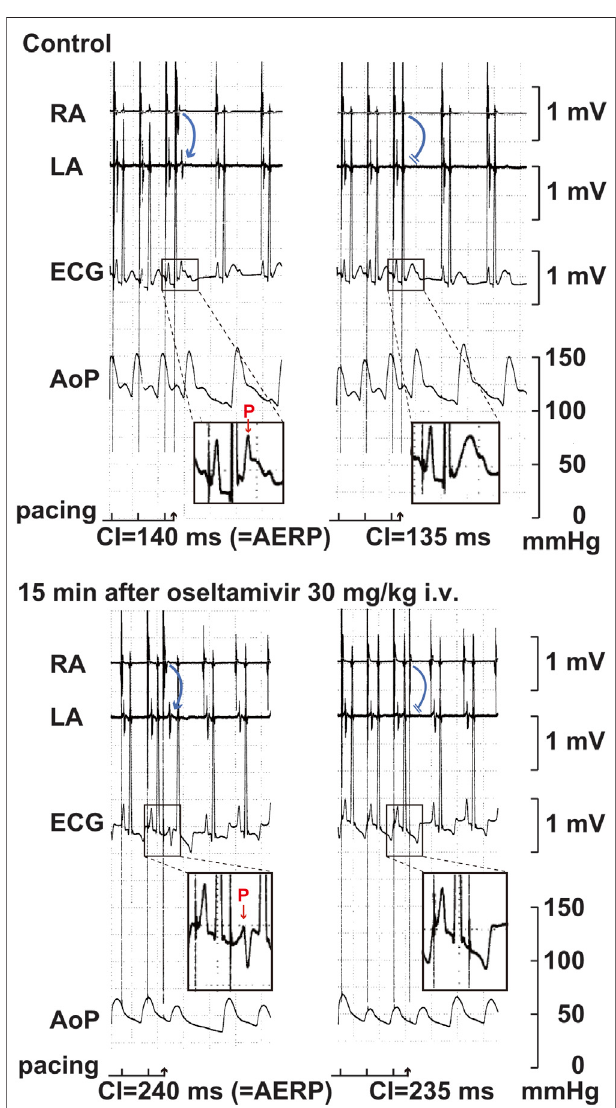
FIGURE 5 | Typical tracings of the right (RA) as well as left (LA) atrial electrograms,electrocardiogram(ECG)andaorticpressure(AoP)duringtheatrial programed electrical stimulation for the assessment of atrial effective refractory period(AERP)ata basicpacing cyclelengthof400 ms atpre-drugcontrol (Control; upper panels ) and 15 min after the start of intravenous administration of30 mg/kgofoseltamivir(15 minafteroseltamivir30 mg/kgi.v.; lowerpanels ). Aprematurerightatrialstimulationwithacouplinginterval(CI)of140 msinduced electrical activity in LA electrogram (blue arrow) and p wave in ECG (red arrow) (upper left) , whereas that of 135 ms failed to develop either of them (upper right) ,indicatingthattheAERPwas140 ms.Aftertheadministrationoseltamivir, a premature right atrial stimulation with a CI of 240 ms induced the electrical activityand p wave (lowerleft) ,whereasthatof235 msdidnotdevelopeitherof them (lower right) , indicating that the AERP was 240 ms. Administration of 30 mg/kg of oseltamivir decreased the aortic pressure. Moreover, the programmed atrial stimulation-induced atrial tachycardia followed by atrial premature contraction could have enhanced the hypotensive action.